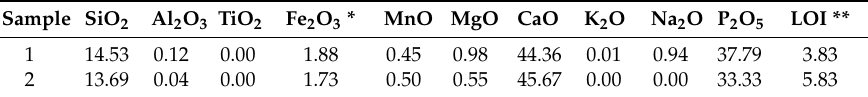
Table 2. Conversion of % oxide values to atomic %, and calculated Ca:P ratios.